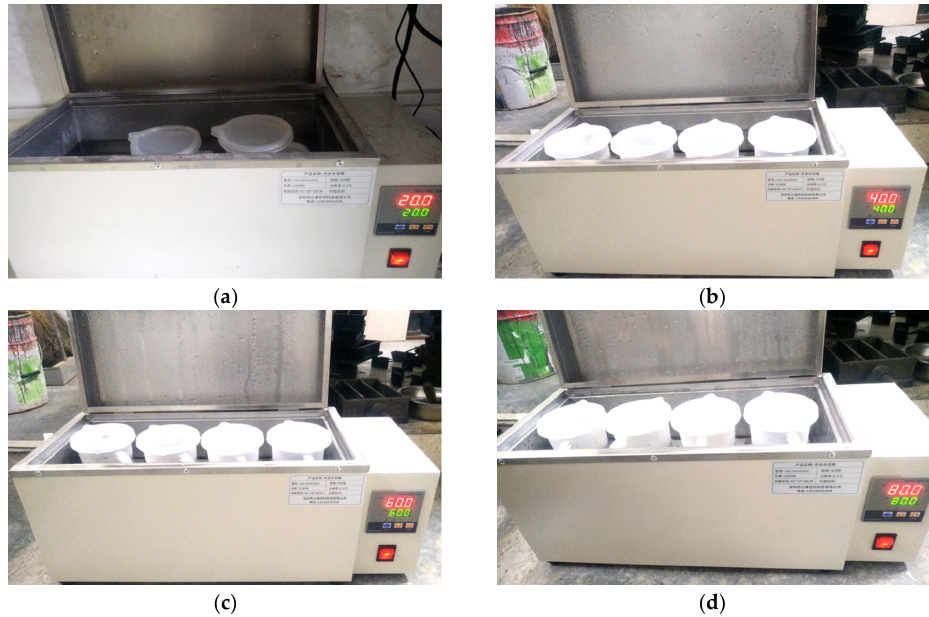
Figure 5. Experimental materials preheating. ( a ) Preheating temperature is 20 °C; ( b ) preheating